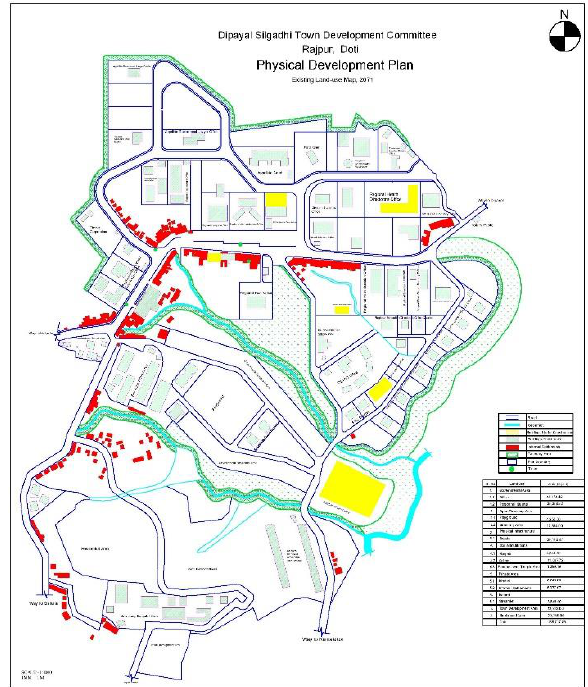
Figure 8. Land use Map with Physical Development Plan 2014 of Rajpur Governmental Area under Dipayal Silgadhi Town Development Committee in Doti district.